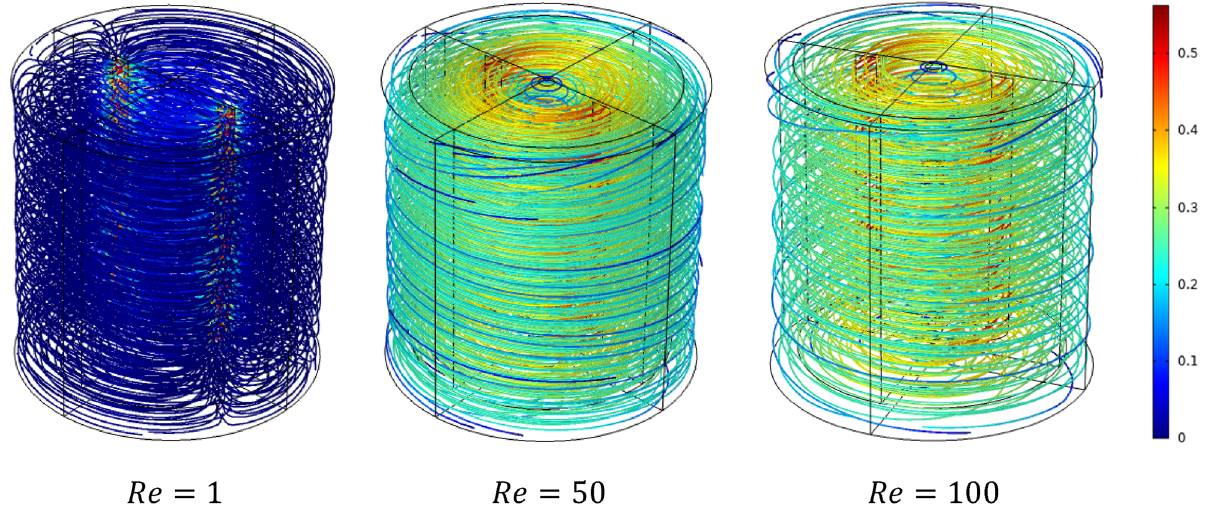
Figure 17. Streamline distribution along stirred vessel for Bn = 50 with inertia variation value.